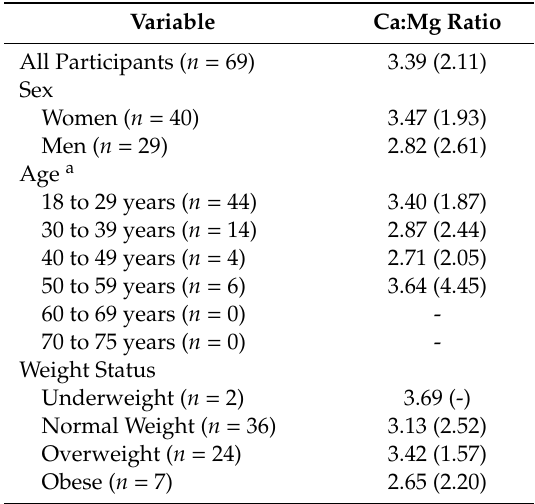
Table 5. Calcium to magnesium intake ratio from the food frequency questionnaires by sex, age, and body mass index.